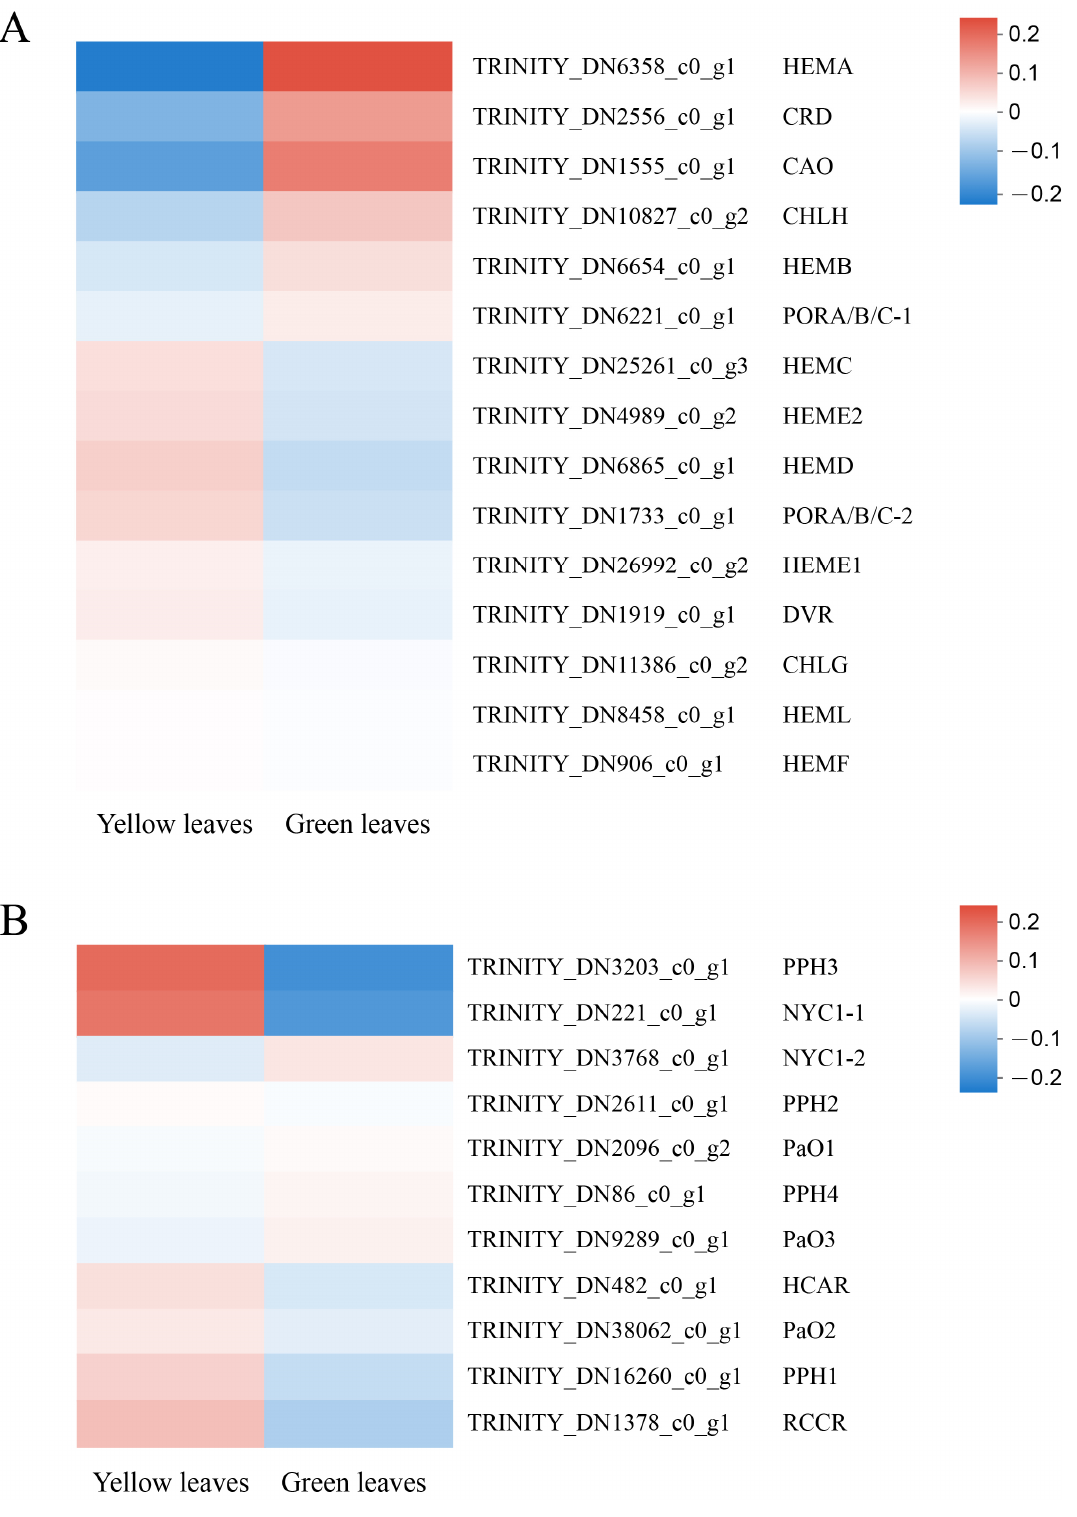
Figure 7. Expression profiles of unigenes involved in chlorophyll biosynthesis and degradation. The computing method of the expression profiles: The logarithm value of unigene TPM in each sample was first taken, and then hierarchical clustering is used for standardization. ( A ) 15 unigenes related to Chl biosynthesis. ( B ) 11 unigenes associated with Chl degradation.